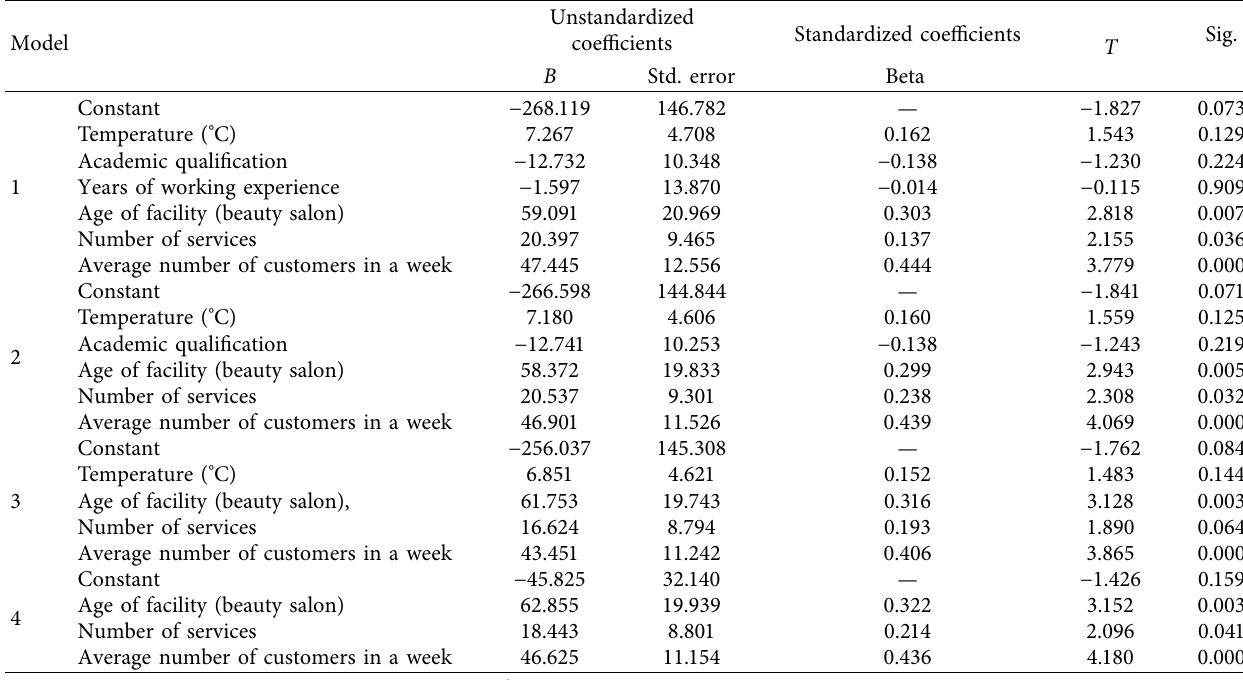
Table 6: Multiple linear regression estimates including the intercept and the significance